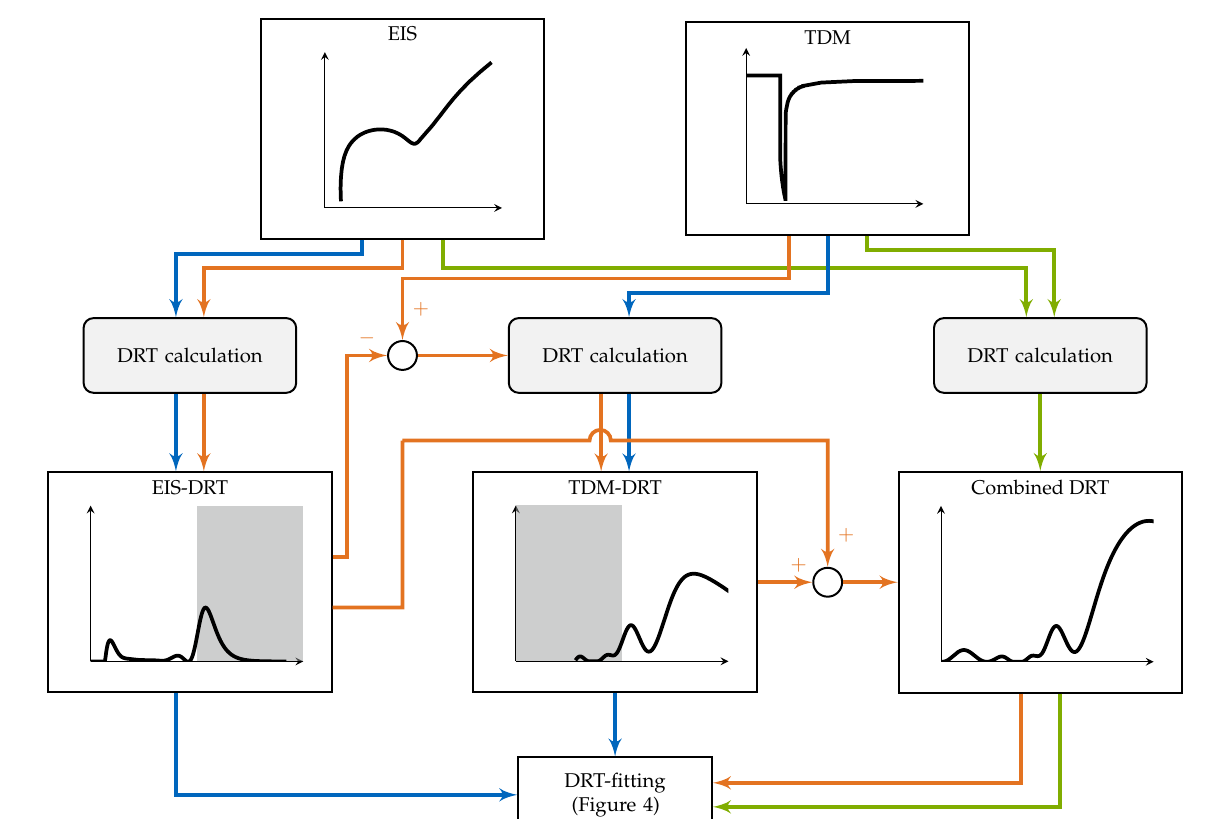
Figure 6. Flow chart of different approaches for combining EIS and TDM before the DRT-fitting is performed to parameterize the RC elements of an ECM. Blue: Separate DRT-fitting. Orange: Interconnected DRT-fitting. Green: Combined DRT-fitting.